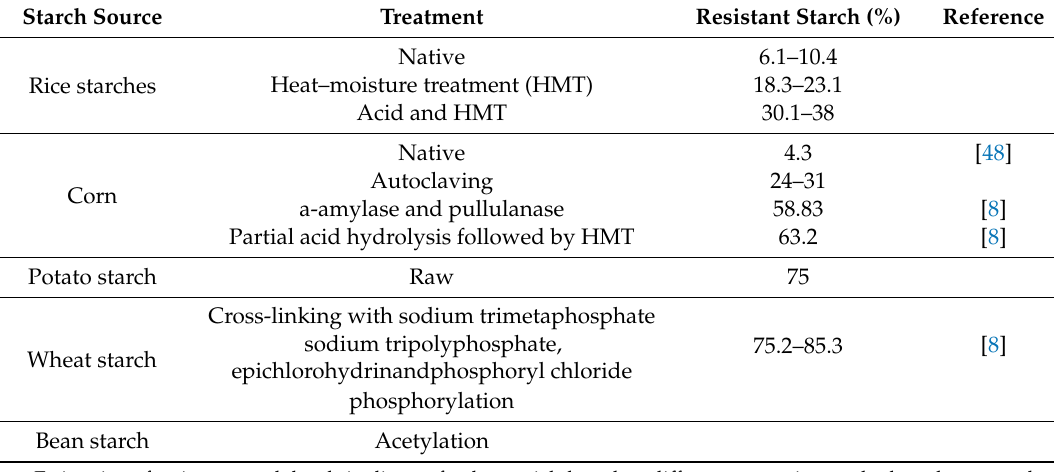
Table 2. Preparation of resistant starch in starch-rich products by di ff erent treatments. Starch Source